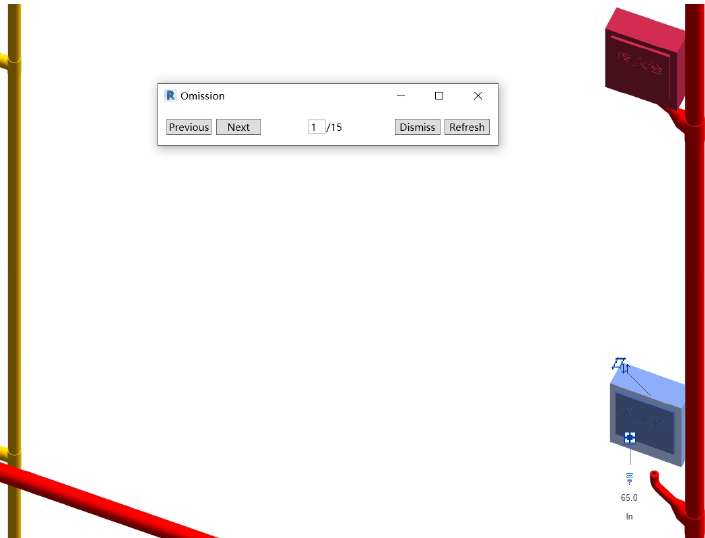
Figure 14. Checking results of the system integrity.